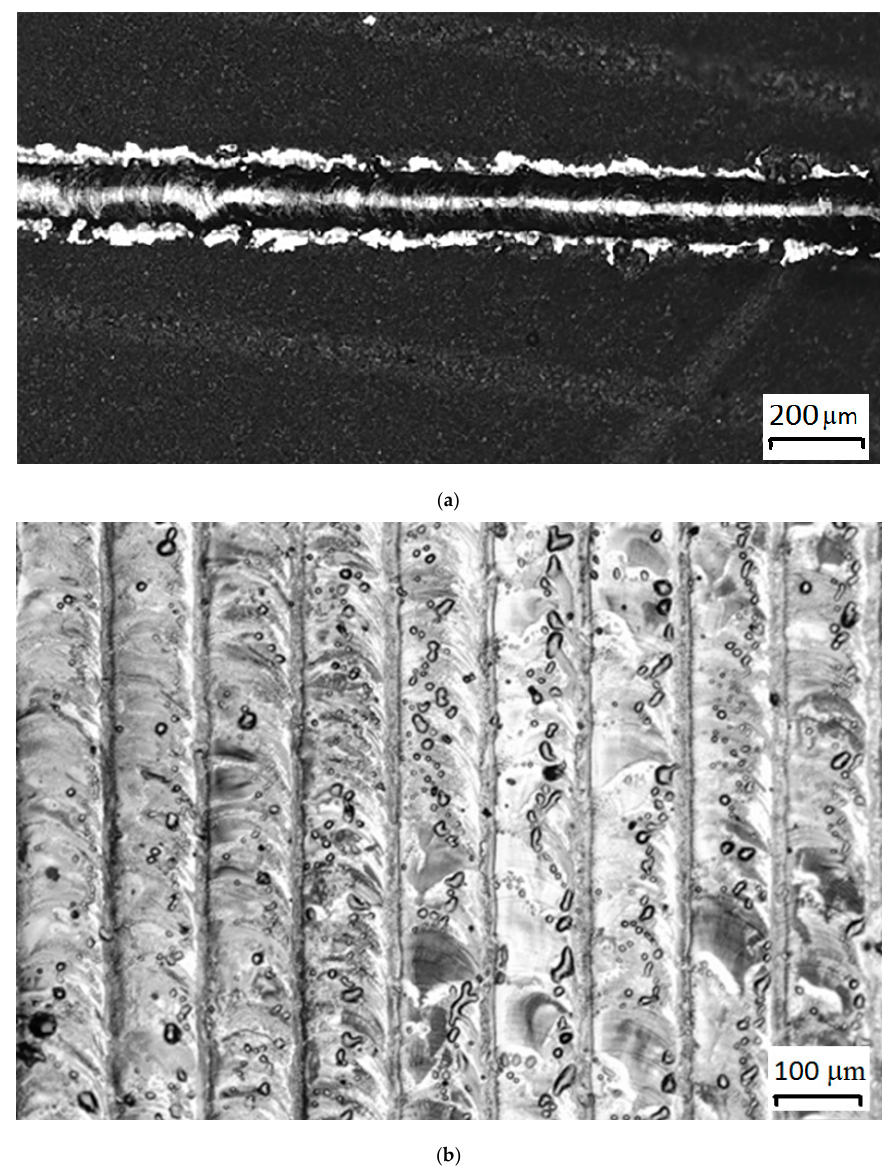
Figure 9. Samples on the substrate, BK20, hard alloy with a content of 20% Co: ( a ) single track of 94 wt% WC and 6 wt% Co, P = 70 W, V = 300 mm/s, N = 20 μ m. ( b ) monolayer of 94 wt% WC and 6 wt% Co P = 70 BT, V = 300 mm/s, N = 20 μ m, s = 70 μ m.